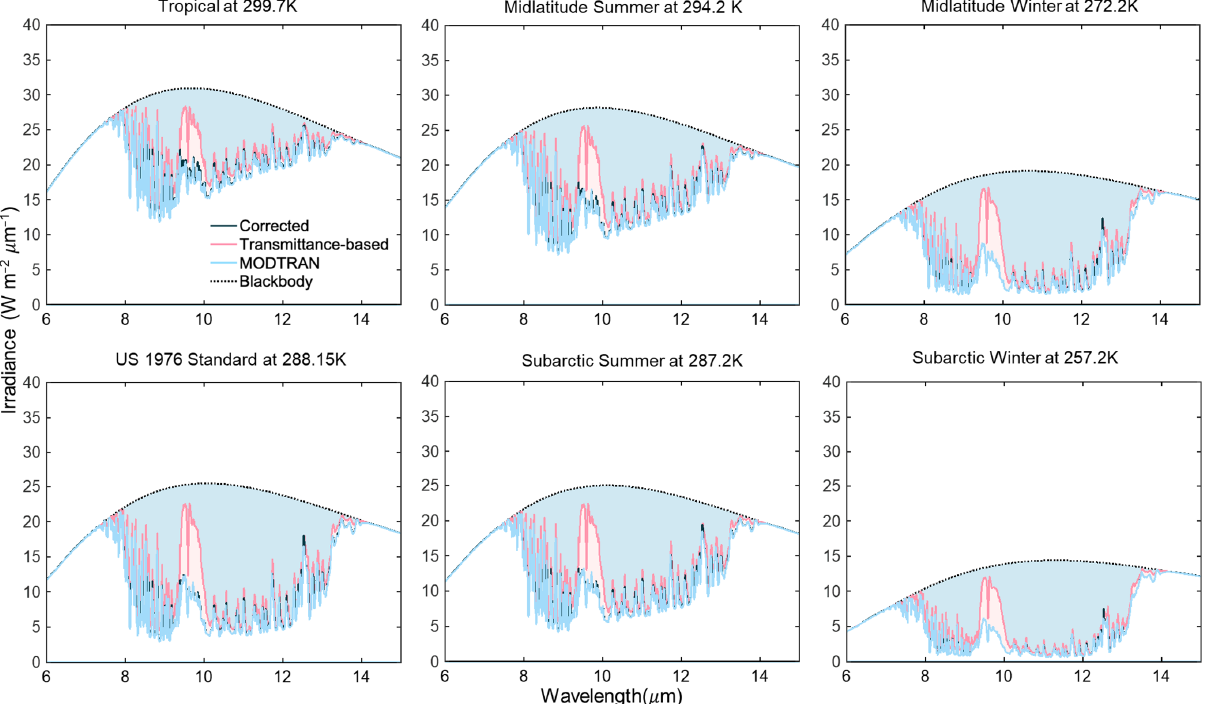
Figure 2. ∆ T ozone and ∆ T rest for the six MODTRAN standard atmospheres: Tropical, Midlatitude summer, Midlatitude winter, US 1976 Standard Atmosphere, Subarctic summer, Subarctic winter.